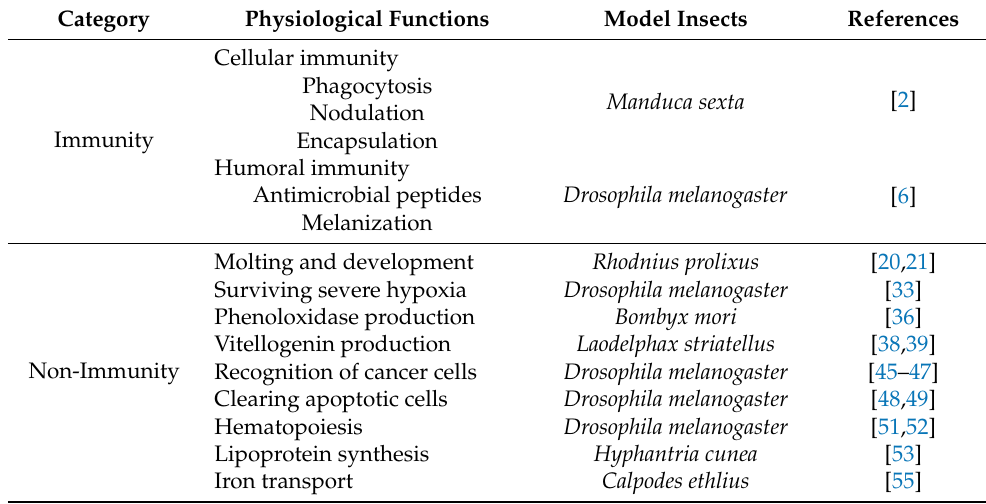
Table 1. Physiological functions of hemocytes in immune and non-immune processes in